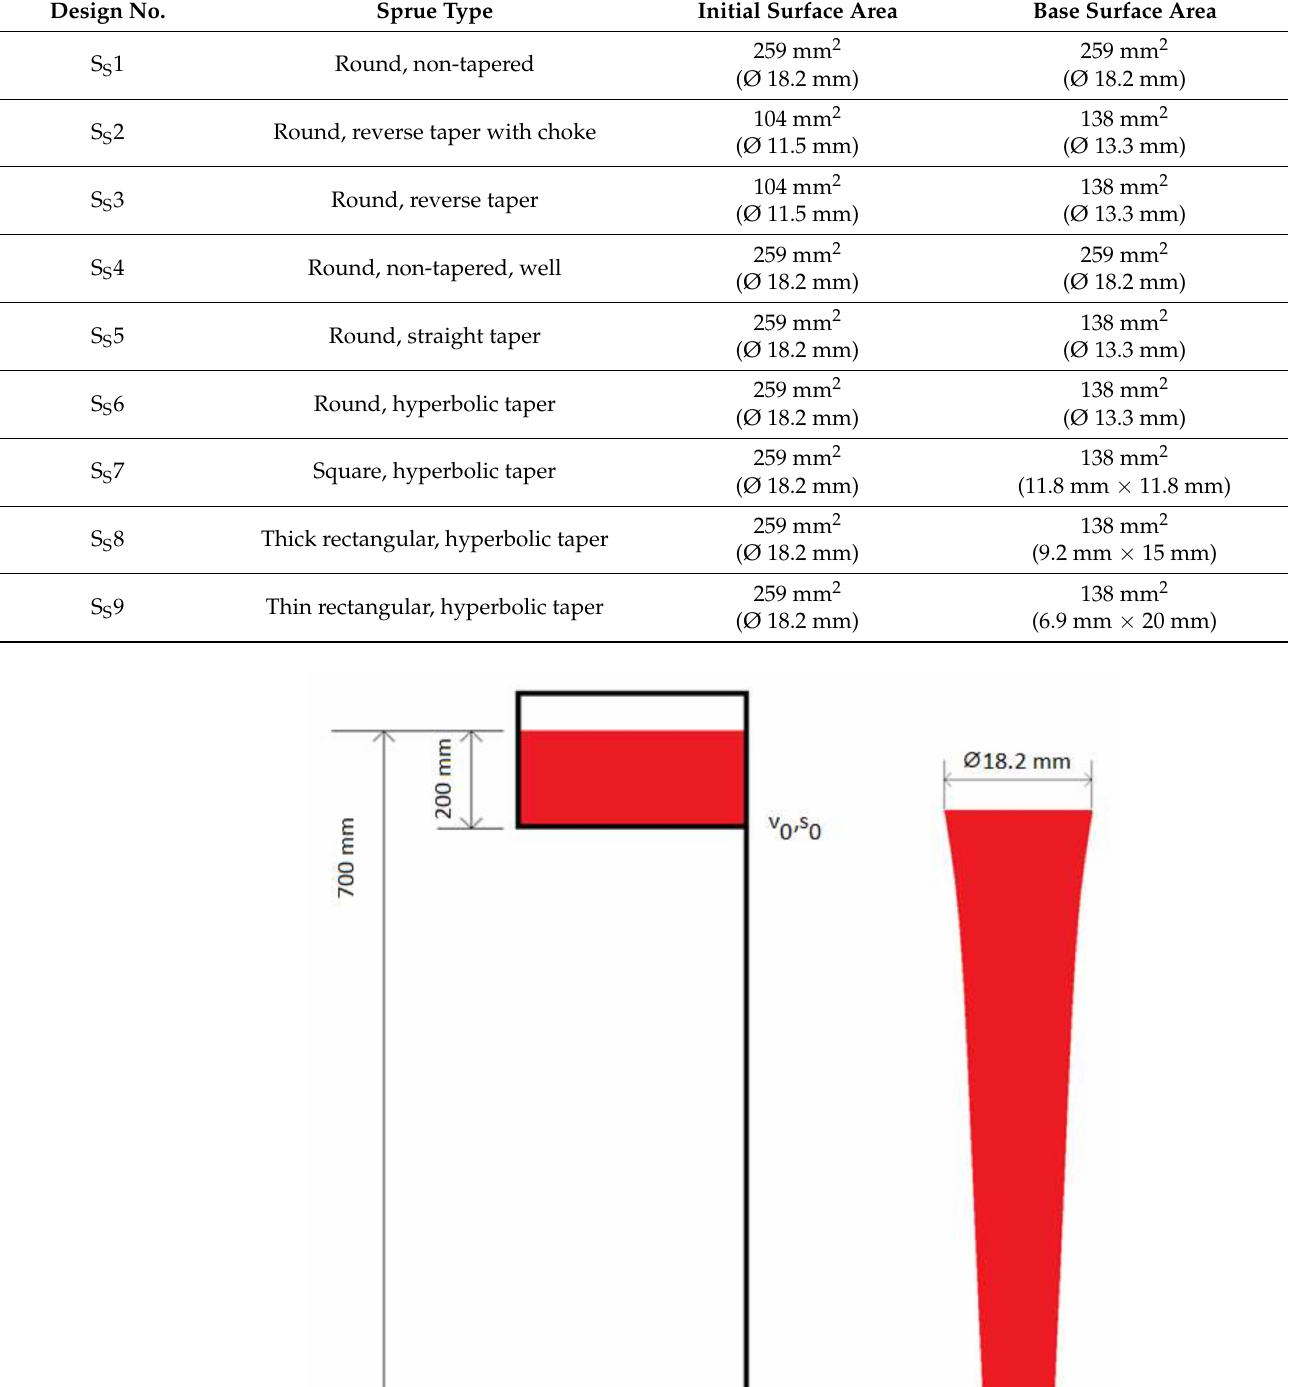
Table 3. Analyzed sprue designs with a length of 500 mm.